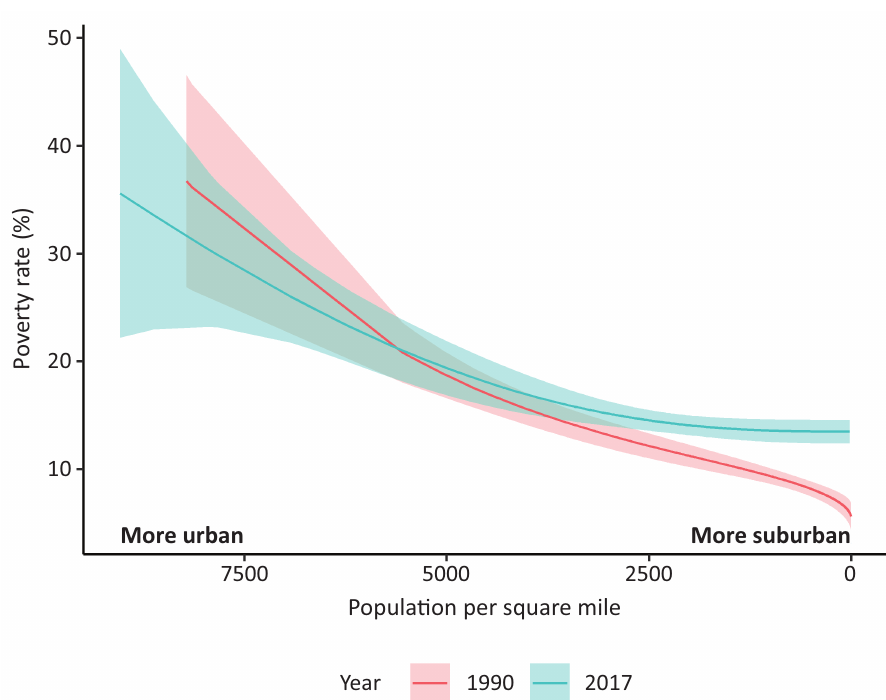
Figure 1. Average census block group poverty rates with 95% confidence bands vs. population density in 1990 and